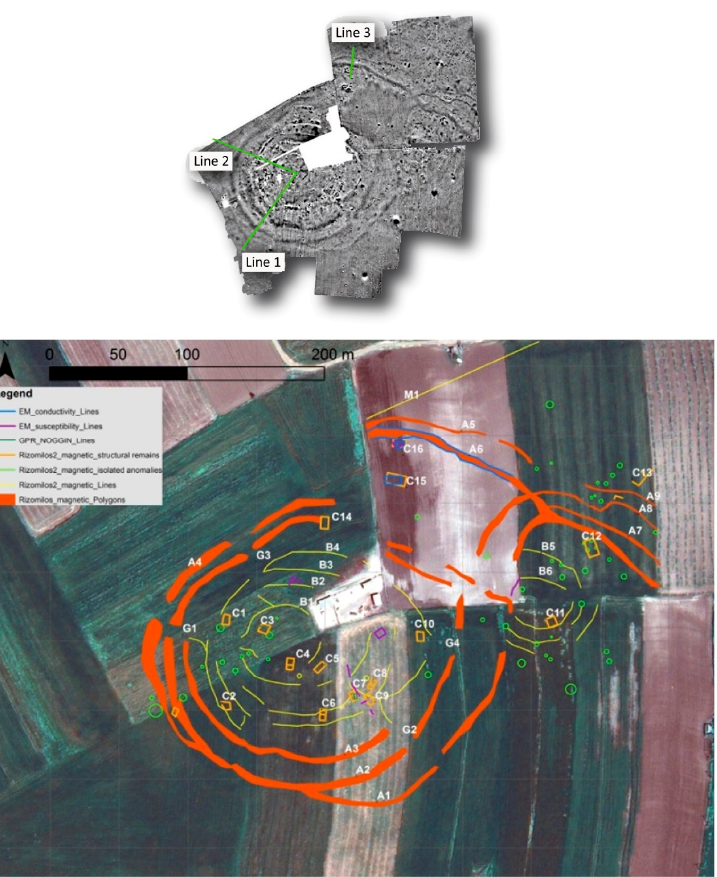
Figure 6. Annotation of the anomalies of interest detected by the geophysical survey at Rizomilos (modified from [19]). The inset at the top shows the related magnetometer results. The grayscale range is the same as that plotted in Figures 1 and 2.